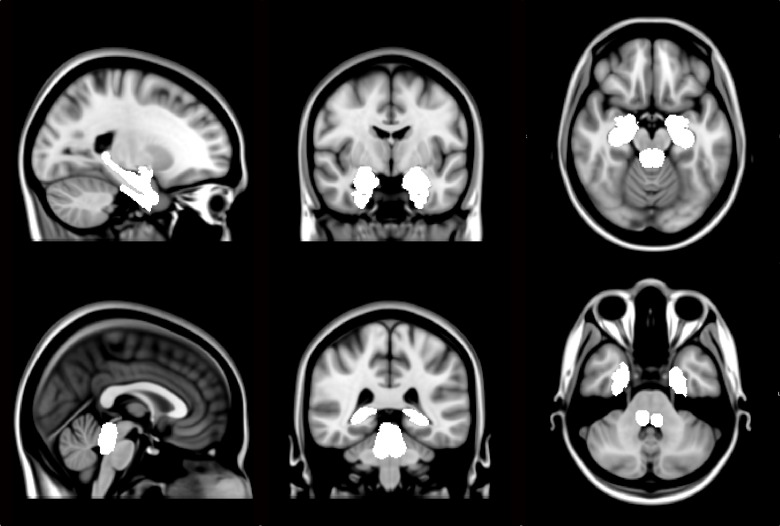
Mask of regions used in the GLM and functional connectivity analyses.Note: Sagittal, coronal and axial slices of the mask that was used for volume correction for the functional connectivity and general linear model analysis (white; overlaid over the MNI 1 mm template).